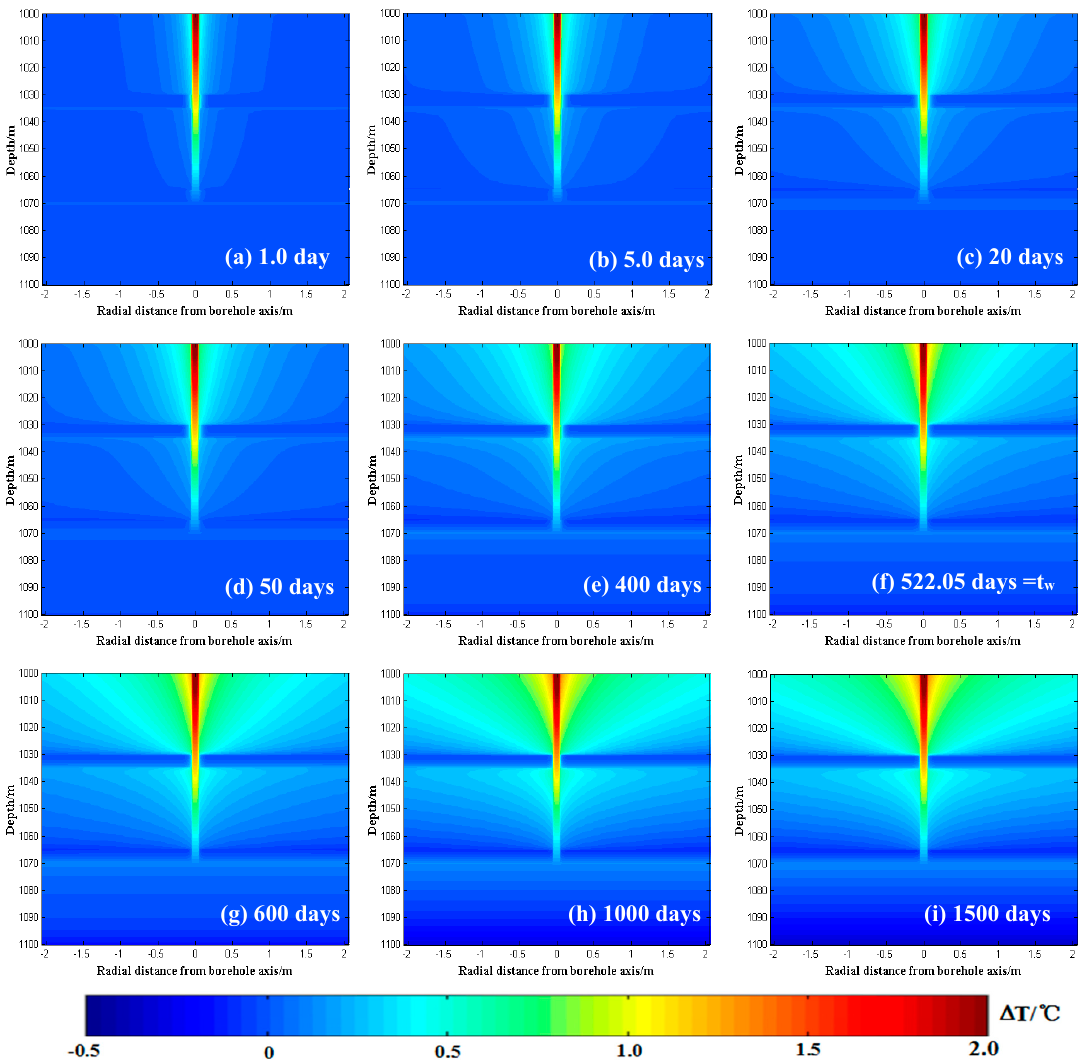
Figure 12. Evolution of the spatial distribution of the downhole temperature variation near the wellbore area (1000 m ≤ z ≤ 1100 m, -2.06m ≤ r ≤ 2.06 m) during the 1500 day period. ( a )–( i ) represent the temperature distribution from 1 day to 1500 days.